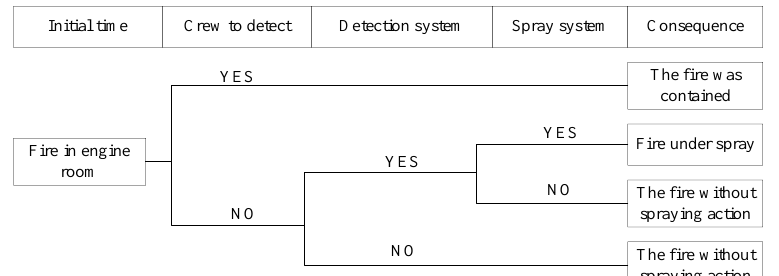
Figure 4. Engine room fire firefighting facilities event